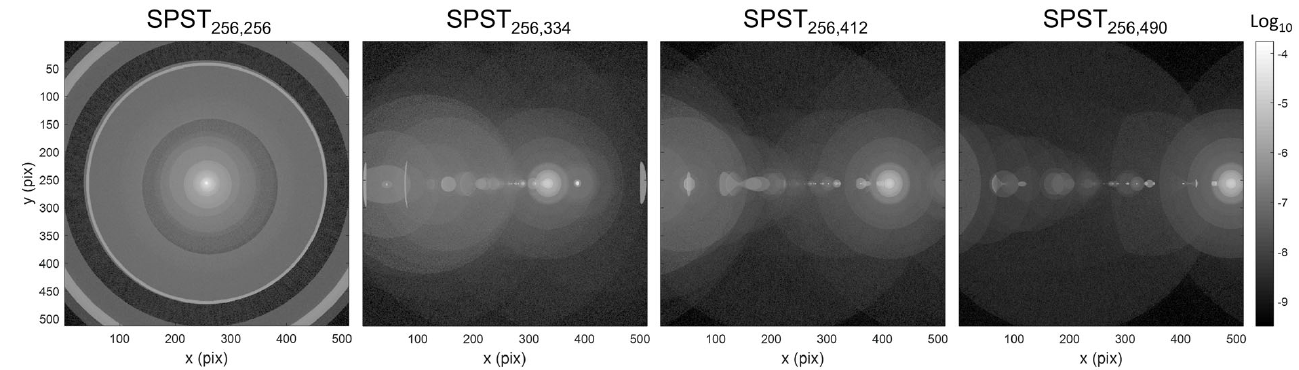
Figure 2. SPST maps for second order ghosts in 3MI, for different fields along the x direction.